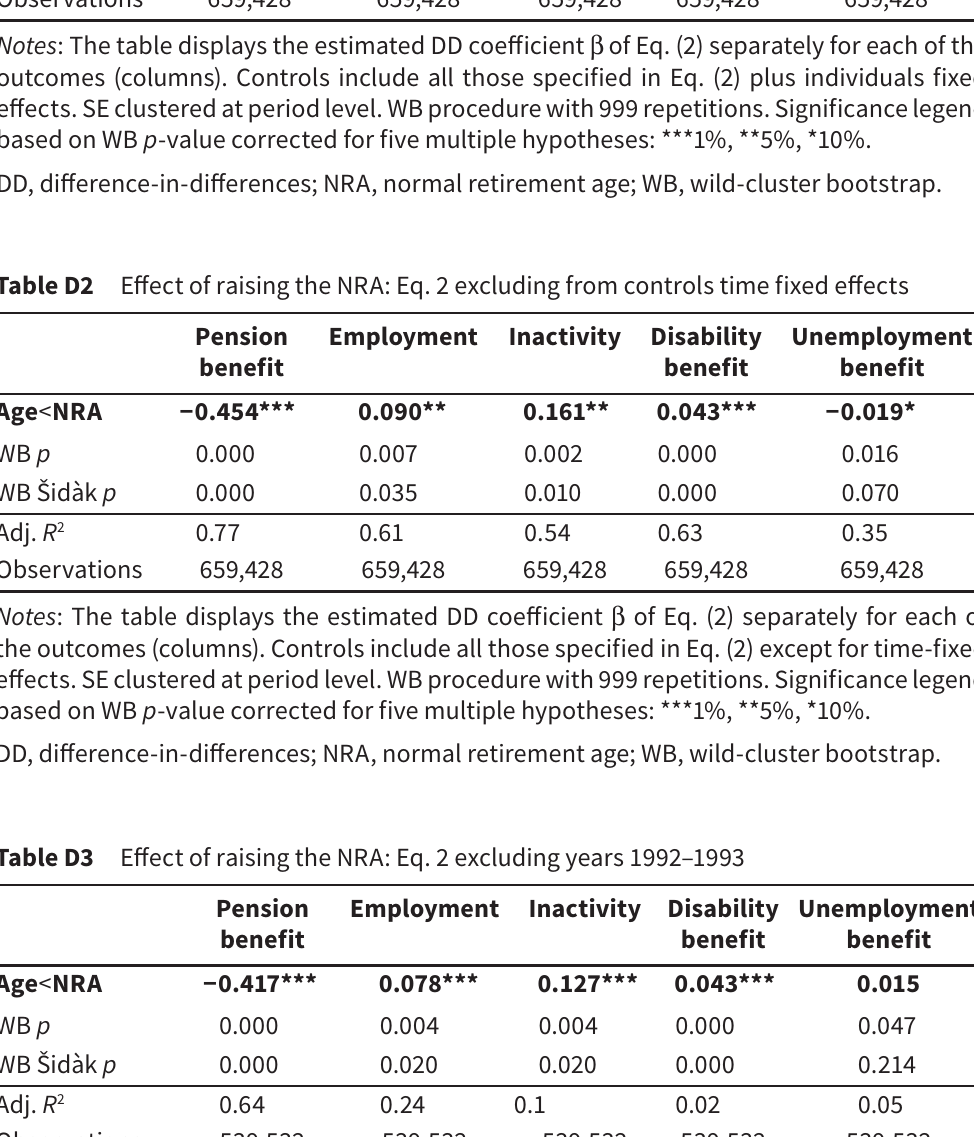
Unemployment benefit